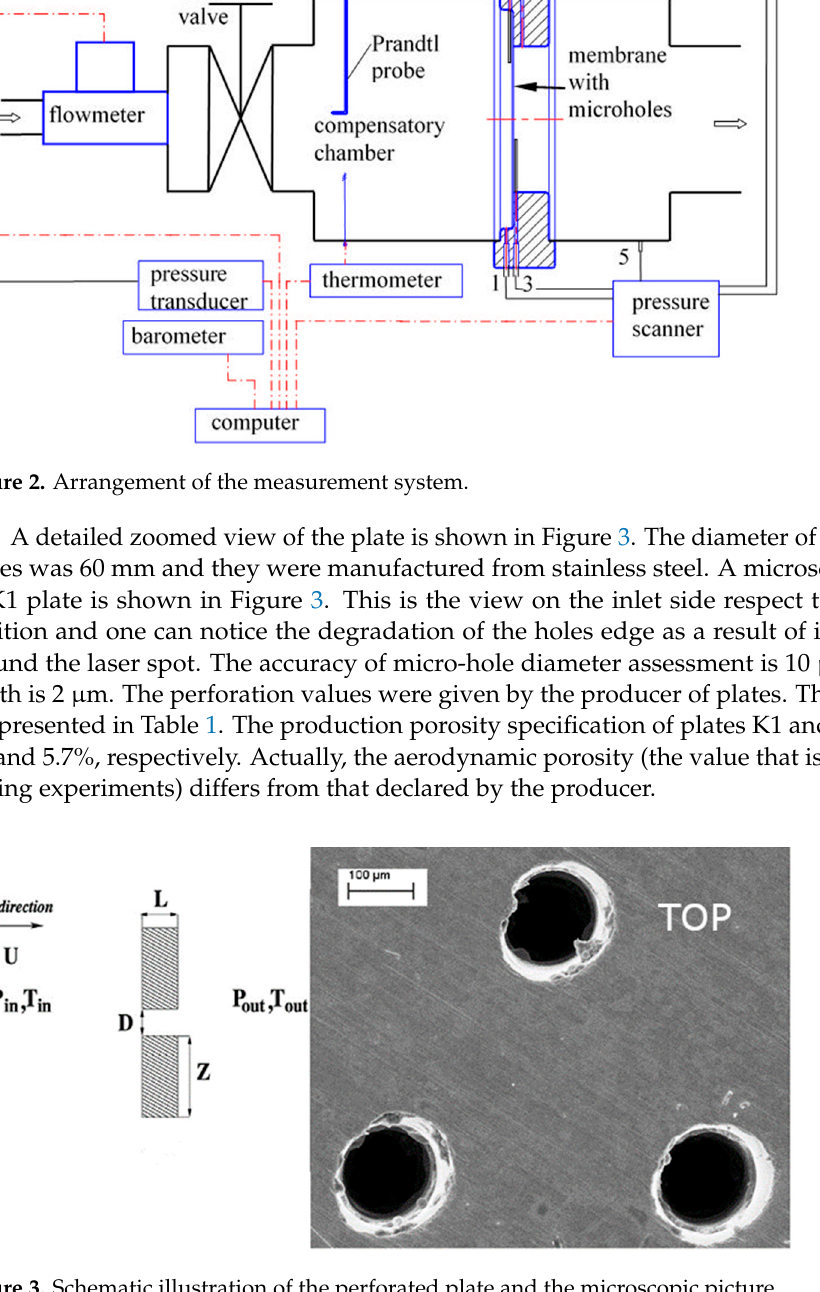
Figure 4. Shape of the hole channel with the velocity direction for the basic ( a ) and reversed ( b ) plate setting; plate K1. Measurement uncertainties were estimated for the mass flow rate and the pressure difference, but they are very small and almost not visible on the picture (they are smaller than the chart points). To calculate the uncertainties of the above-mentioned quantities, exact differentials were used, containing such variables as pressure, temperature and air density. Average value of the obtained measurement errors for the mass flow rate are equal to 1.7%. High-accuracy pressure transducers (MEAS, Hampton, VA, USA) were